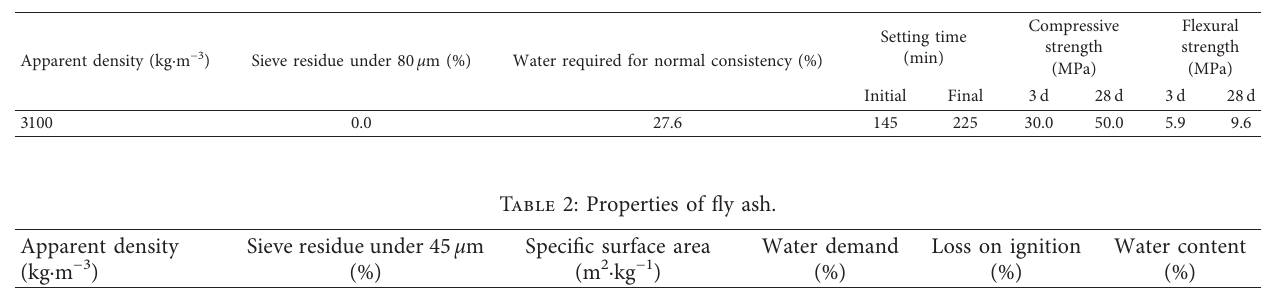
Figure 6: Relationship trend between Mcr and hf/h. Table 1: Properties of Portland cement.